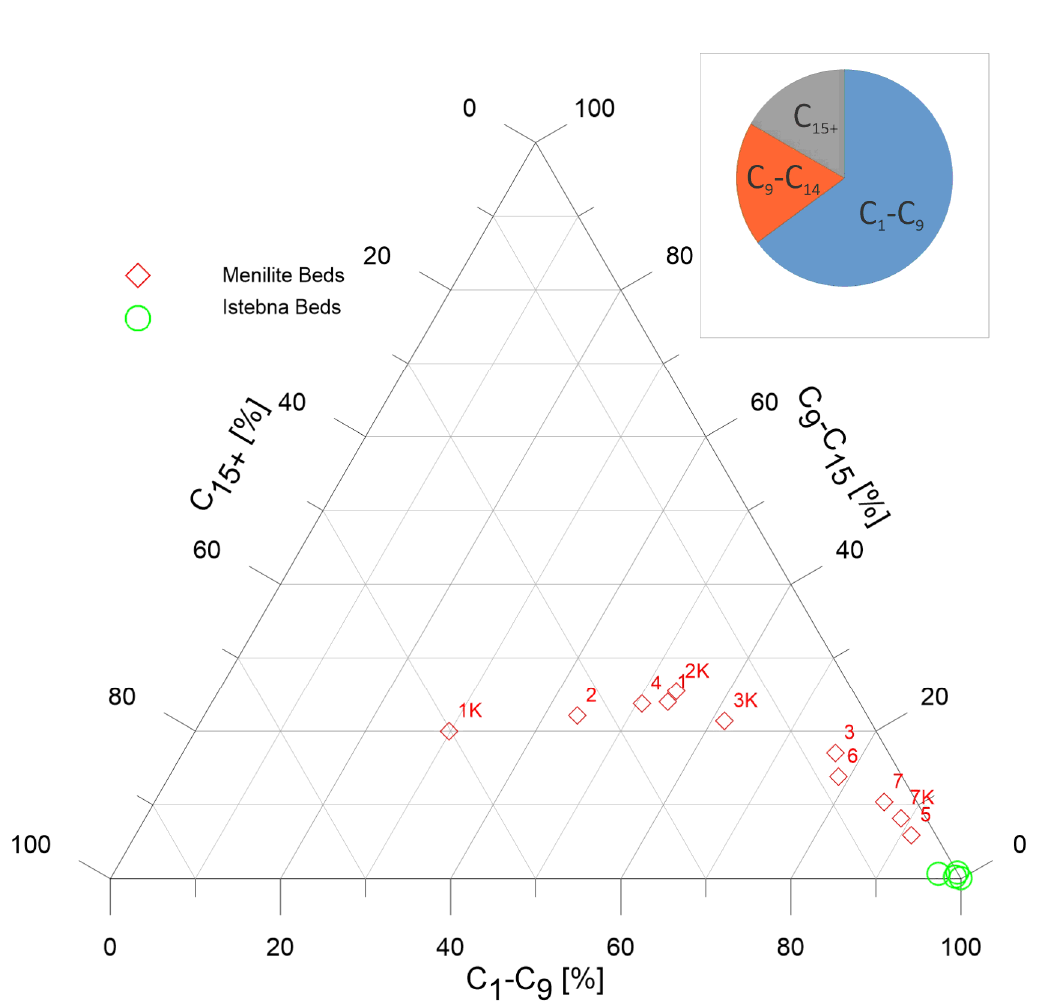
Figure 15. Fractional composition of pyrolysis products of the Menilite Beds, Istebna Beds, and kerogen samples from the Menilite Beds in the range of 300–650 °C and the average fractional composition for the Menilite Beds.